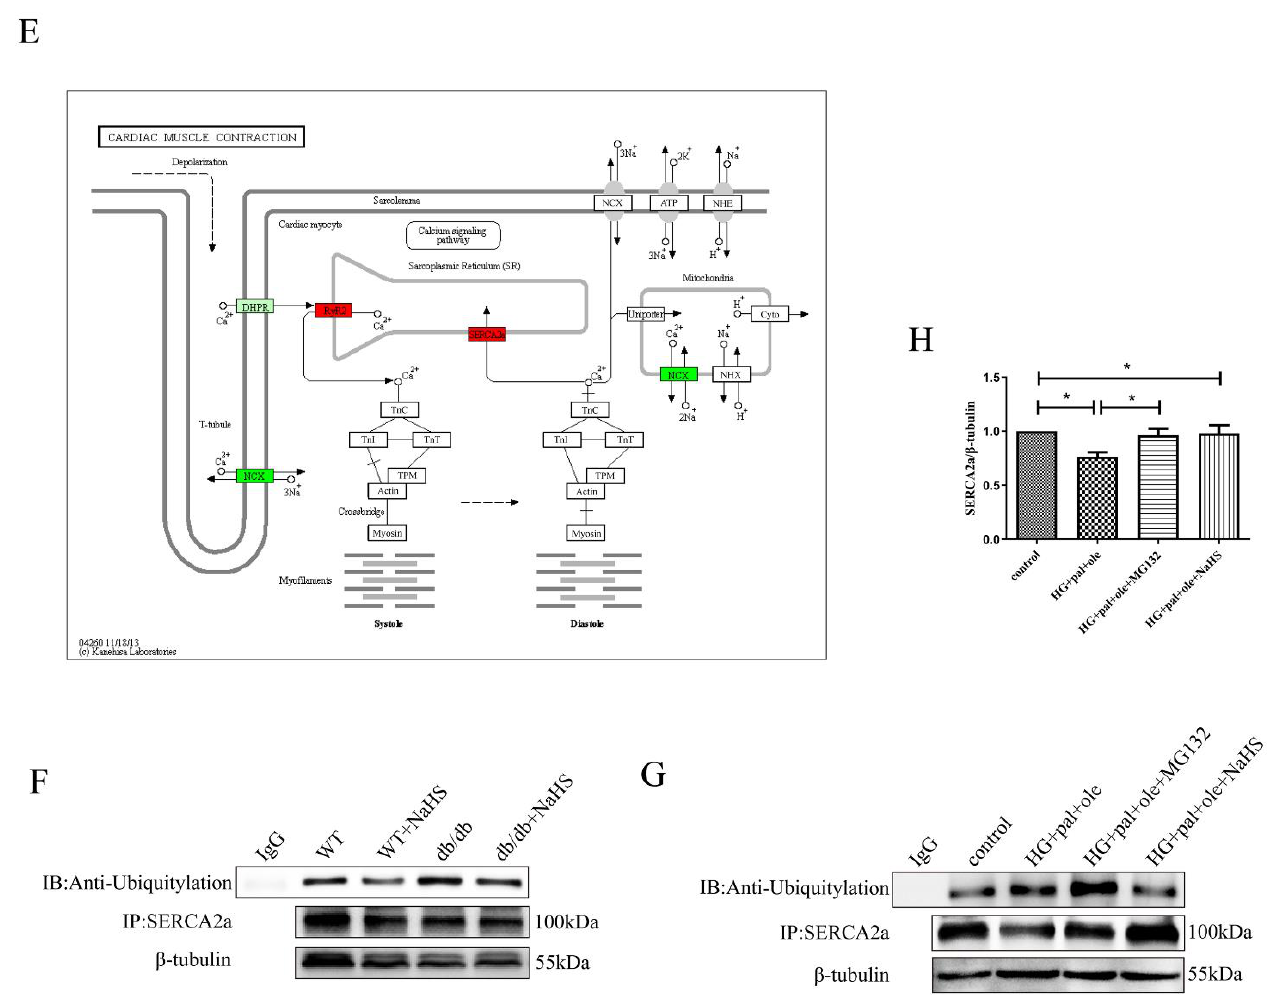
Figure 3. Exogenous H 2 S upregulated SERCA2a in cardiac tissues of db/db mice via inhibiting ubiquitin-proteasome pathway. Affinity enrichment was normalized using KEGG standard peptides, followed by a label-free quantitative proteomic strategy for quantitative lysine ubiquitination analysis of mouse cardiac tissue. GO annotation divides proteins into three categories: cell compartment, molecular function, and biological process. Kub protein quantized in this study is divided into four quantiles according to the quantized proportion: Q1 (0~15%), Q2 (15~50%), Q3 (50~85%), and Q4 (85~100%). Calculate the relative fold change between the db/db model mice and the db/db+NaHS mice. Green means score < 0, and the ratio is lower than the average. Red indicates that the score > 0, and the ratio is greater than the average value. ( A ) Cellular Component. ( B ) Molecular Function. ( C ) Biological Process. ( D ) KEGG pathway analysis was identified by bioinformatic analysis. ( E ) The pathway obtained from KEGG pathway enrichment analysis. The proteins in bright green are down-regulated and the proteins in red are up-regulated. ( F ) Cardiac tissue lysate was immunoprecipitated with anti-SERCA2a antibody and then immunoblotted with antibodies specific for Ubiquitylation. ( G ) The NRCMs were immunoprecipitated with an anti-SERCA2a antibody and then immunoblotted with antibodies specific for Ubiquitylation. ( H )After being treated with MG132, the expression of SERCA2a was assessed by Western blotting in the NRCMs. Values are presented as the mean ±standard errors from n = 6 replicates. * p < 0.05.